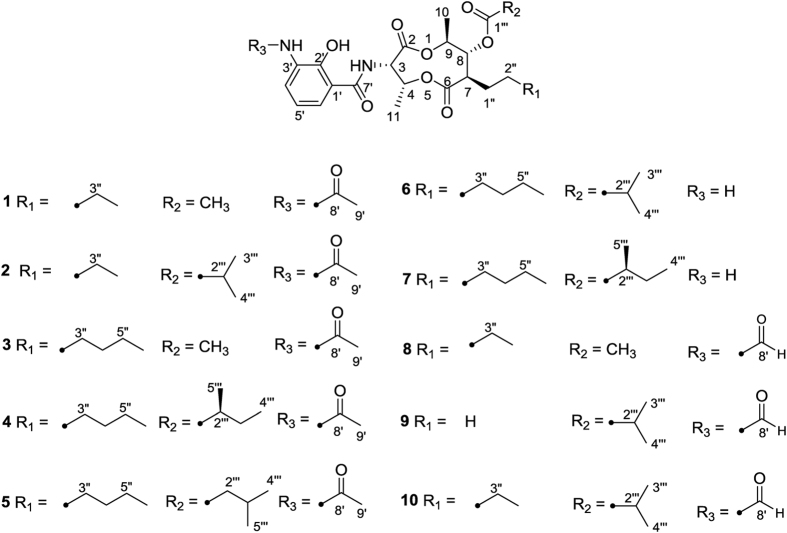
Structures of compounds 1–10.